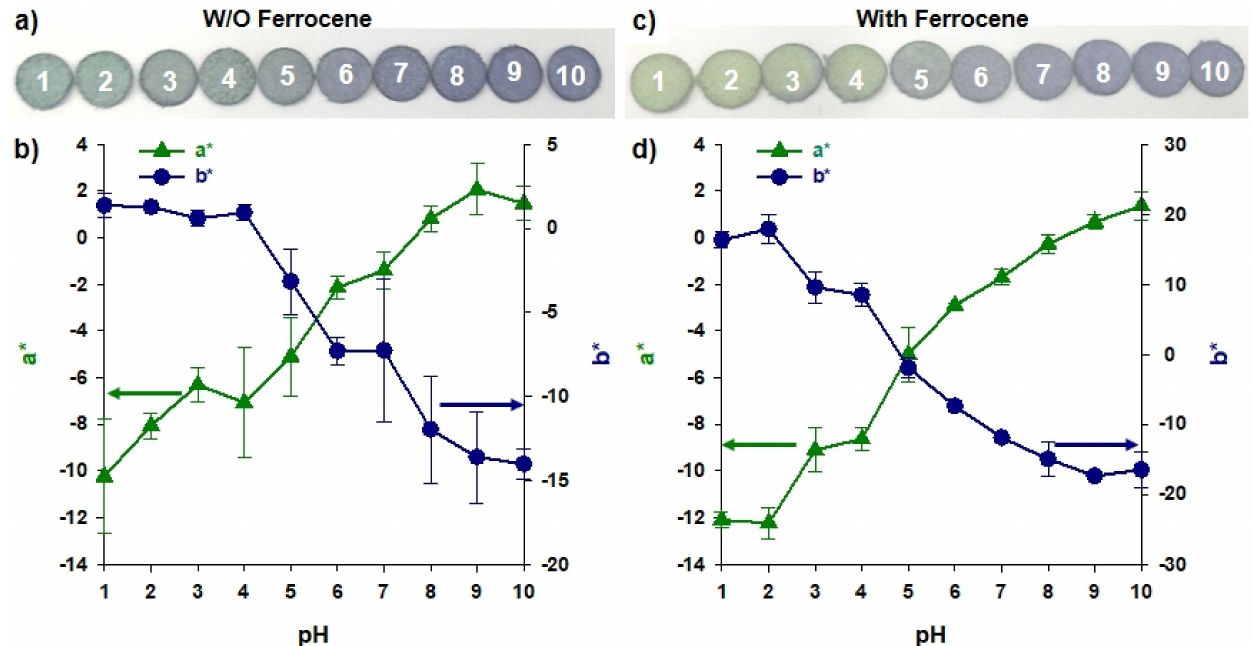
Figure 4. ( a ) Photograph and ( b ) a* and b* values of each TPAni paper sensor platform according to pH ( n = 10). ( c ) A photograph and ( d ) a* and b* values of each TPAni paper sensor platform according to pH after ferrocene treatment ( n =